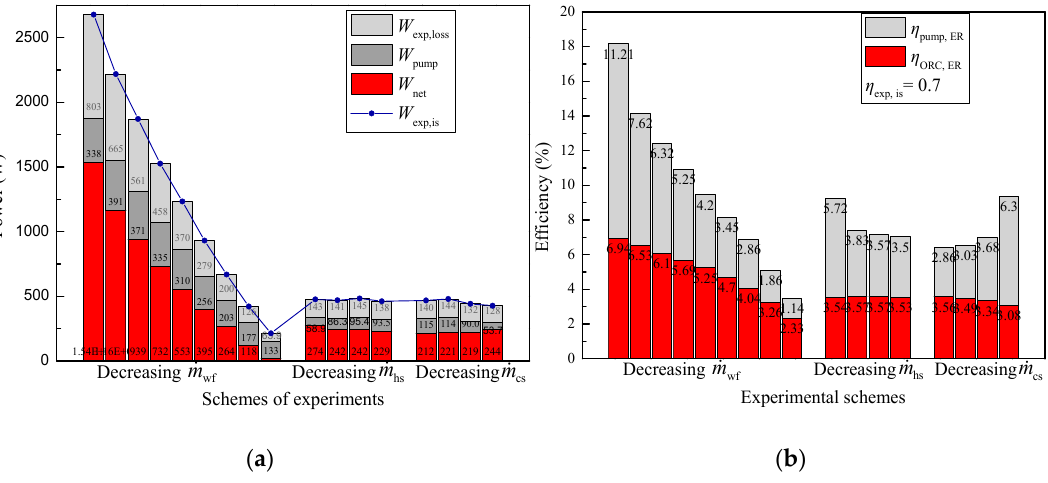
Figure 11. Steady-state performance predicted for experimental working conditions: ( a ) power analysis; ( b ) efficiency analysis.